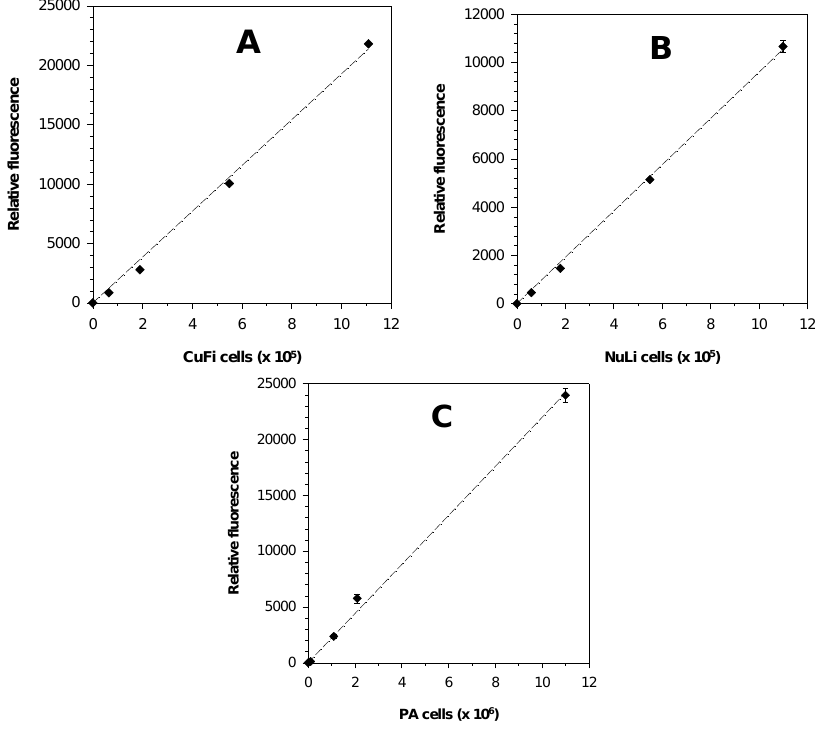
Figure 3. Calibration plots of PKH stained cells. Relative fluorescence of cells was determined on a spectrofluorometer (Tecan Infinite M200 Pro) set for PKH67 (Ex 522 nm, Em 569 nm) and for PKH26 (Ex 470 nm, Em 505 nm). Epithelium cells CuFi and Nuli are shown in plots A and B , respectively. Plot C depicts the calibration line for fluorescently labeled PA. Relative fluorescence of background (blank) was subtracted from that of cell samples. The values are means ± SD of five independent